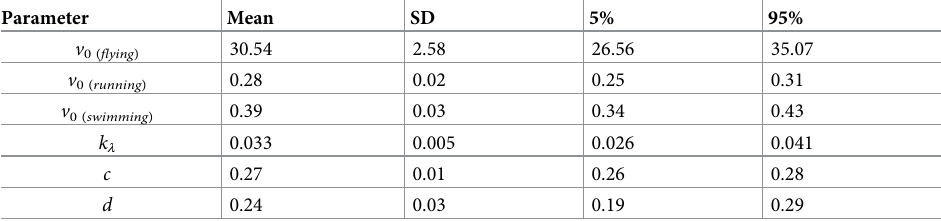
Table entries correspond to the mean, standard deviation (SD), and 90% credible intervals of the model parameters’ posterior distributions (see Table 1 for a description of the model parameters). The data underlying this Table can be found in